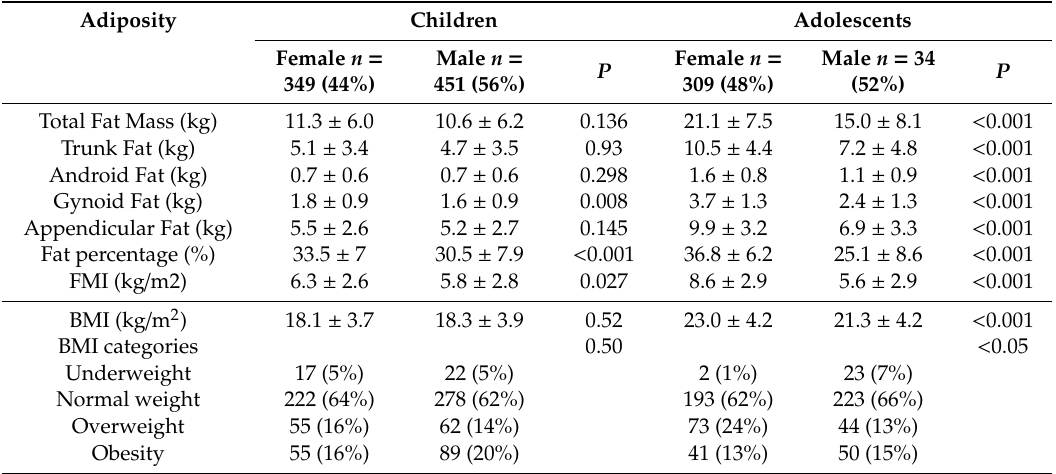
Table 2. Adiposity measurements in Mexican children and